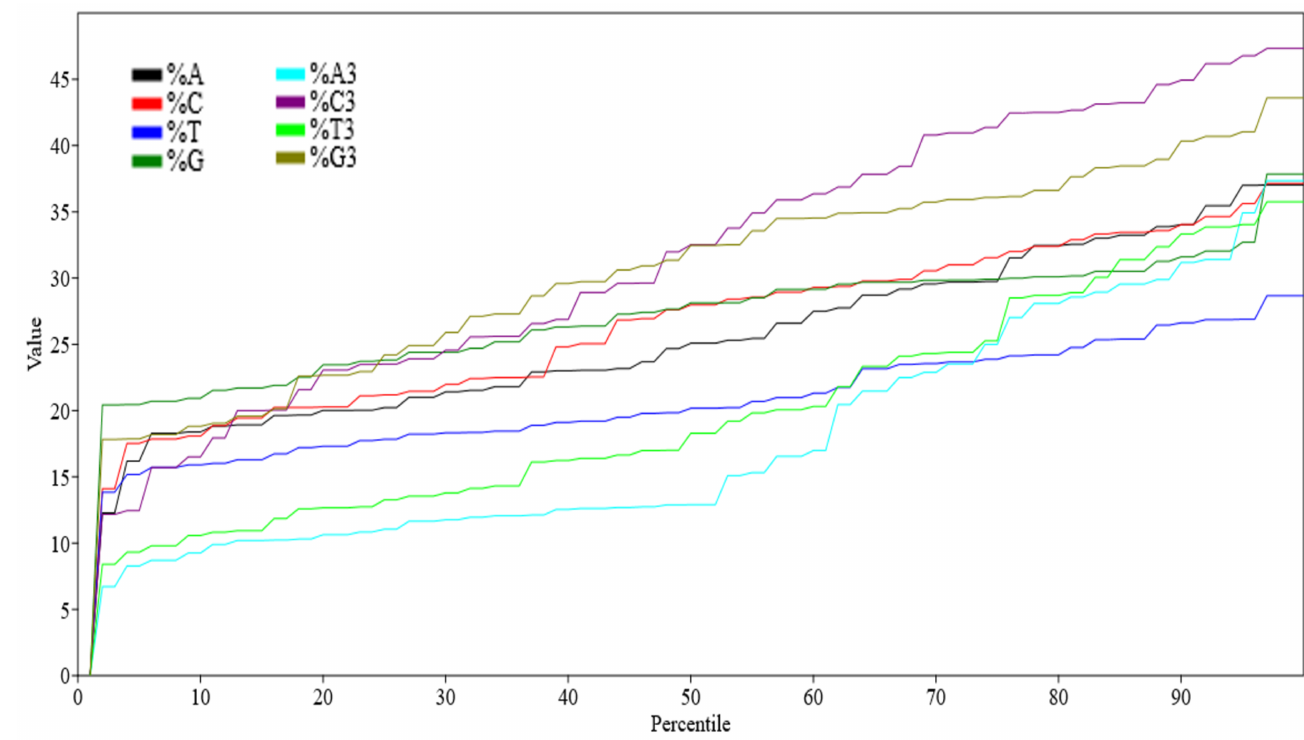
Figure 1. Percentile graph depicting overall nucleotide composition of 42 genes related to